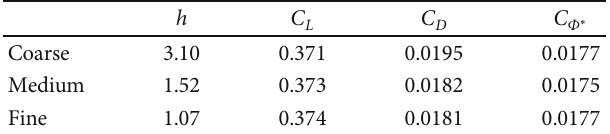
Table 2: Grid re fi nement study result.